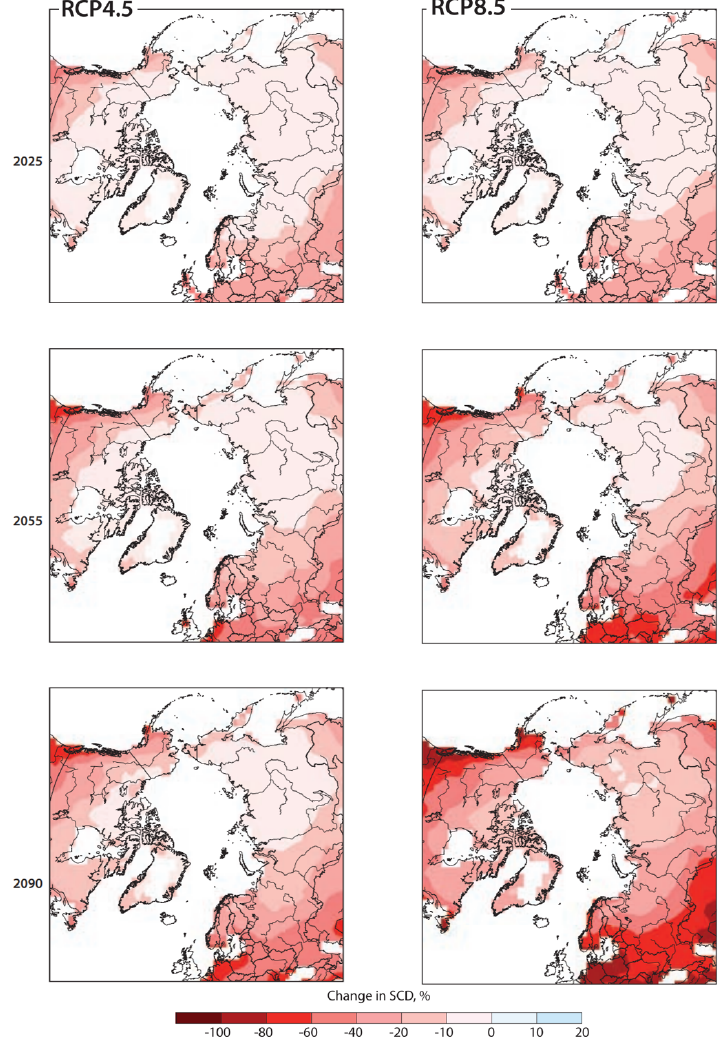
Figure 6. Projected changes in mean annual SCD under RCP4.5 and RCP8.5 scenarios, with respect to 1986–2005 for three 20-year time slices centred on 2025, 2055 and 2090. The map reproduced from [10] with permission from AMAP.